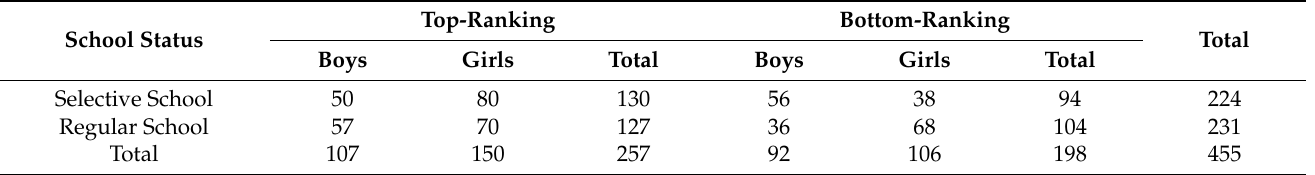
Table 1. Basic information of the valid